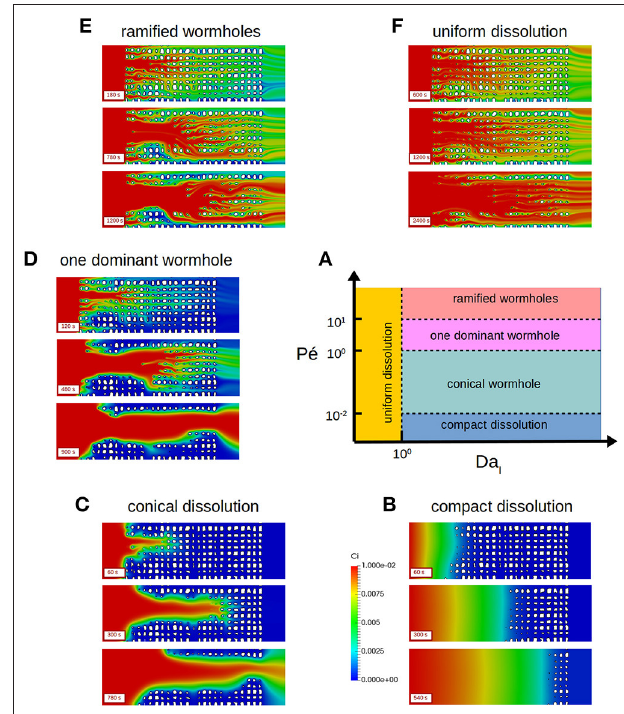
FIGURE 10 | Prediction of the evolution of the pore space of a micromodel for different values of the constant of reaction and of the diffusion coefficient. Five different dissolution regimes are identified (A) namely compact dissolution (B) , conical dissolution (C) , one dominant wormhole (D) , ramified wormholes (E) , and uniform dissolution (F) (Reprinted with permission from Soulaine et al., 2017, Copyright Cambridge University Press 2017).